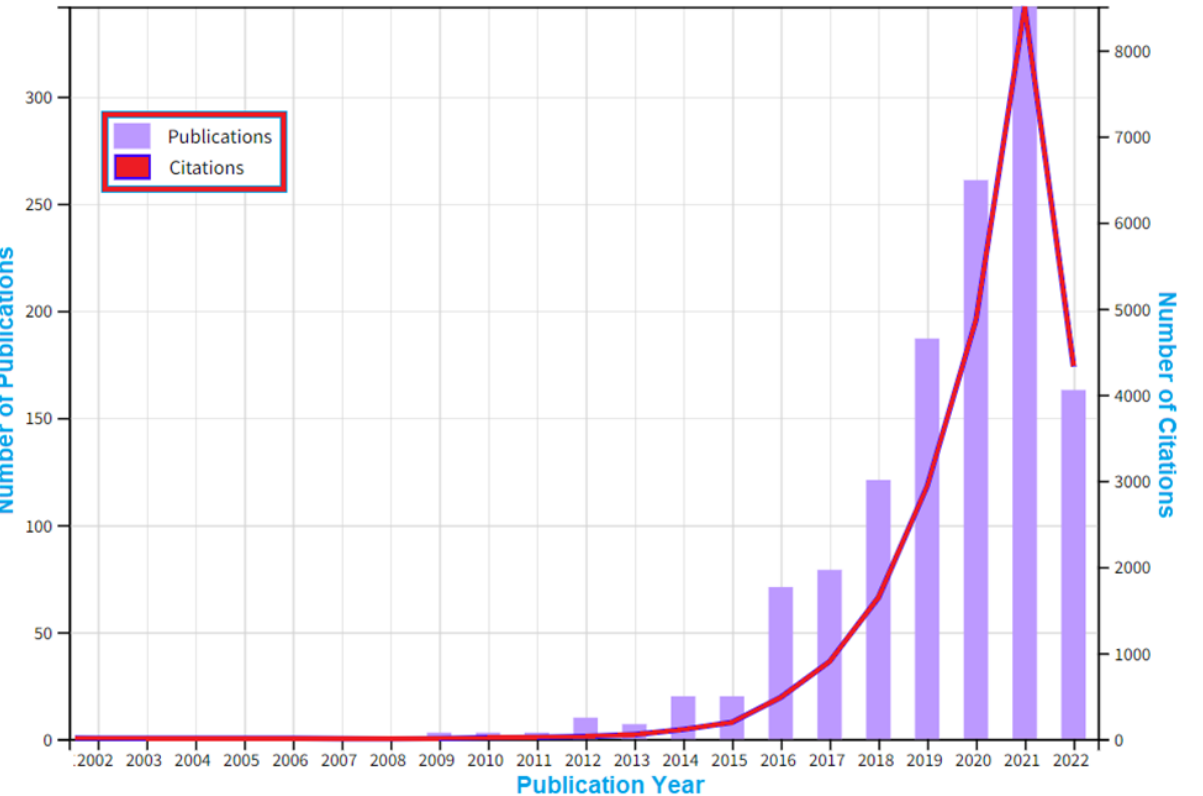
Figure 18. Number of citations and number of publications from 2002 to 2022 for “additive manufacturing on lattice structure” research (data retrieved from WoS on 20 June 2022).